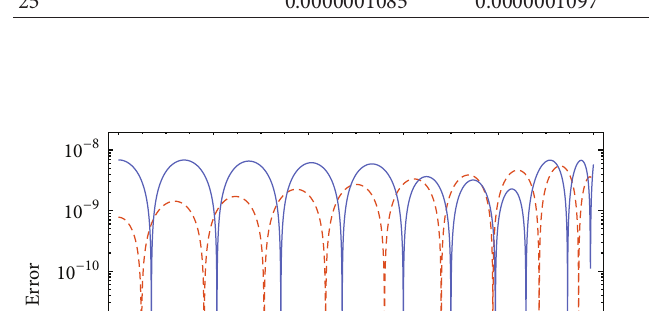
slightly accurate on Γ 2 in both maximum and mean square norm, the proposed method has more significant digits for leading coefficients; see Table